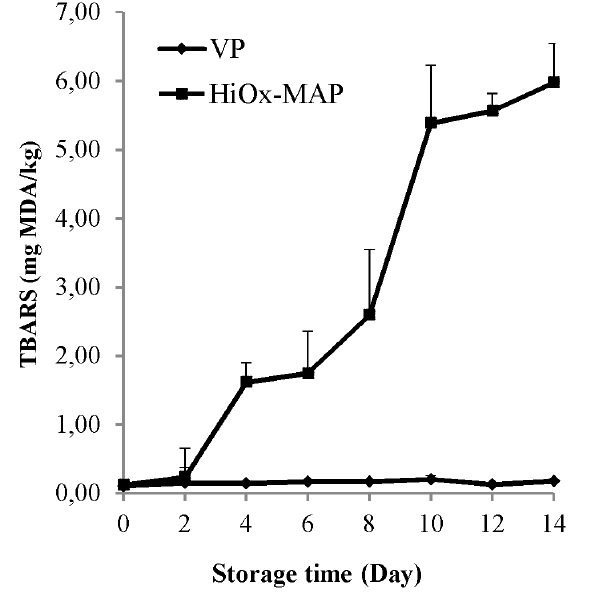
Figure 1. Effects of vacuum packaging (VP) and high-oxygen modified atmosphere packaging (HiOx-MAP, 80% O reactive substances (TBARS) value of minced water buffalo meat at 2°C±0.5°C for 14